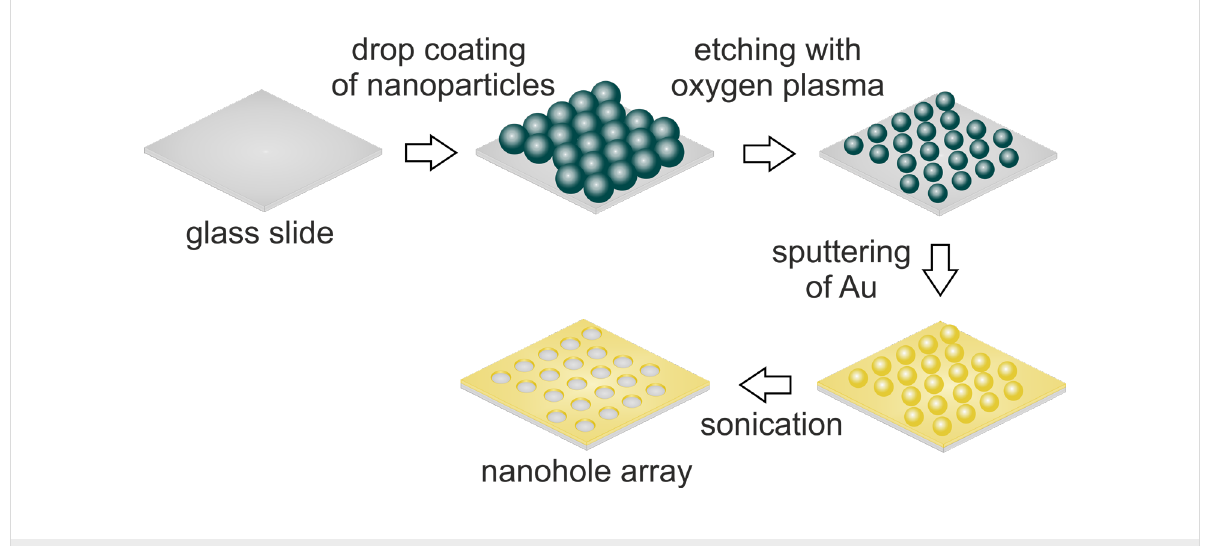
Figure 1: Outline of the fabrication steps to form a nanohole array with a modified nanosphere lithography technique.